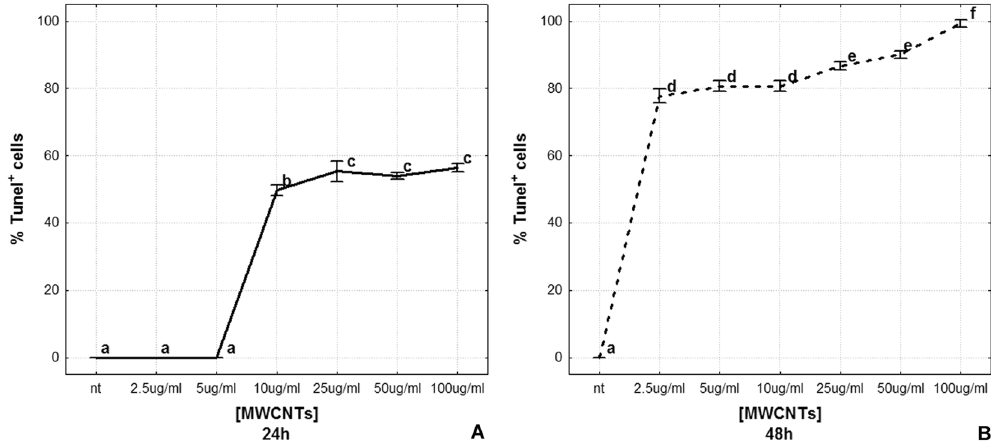
Figure 6. Apoptotic rate after MWCNT in vitro treatment ( A , B ). The graphs illustrate the percentage of TUNEL + cells 24 h ( A ) and 48 h ( B ) after in vitro MWCNT treatment. Statistical differences were calculated by Factorial ANOVA followed by Tukey’s post-hoc test; vertical bars denote standard deviation, different letters indicate statistically significant differences (p <